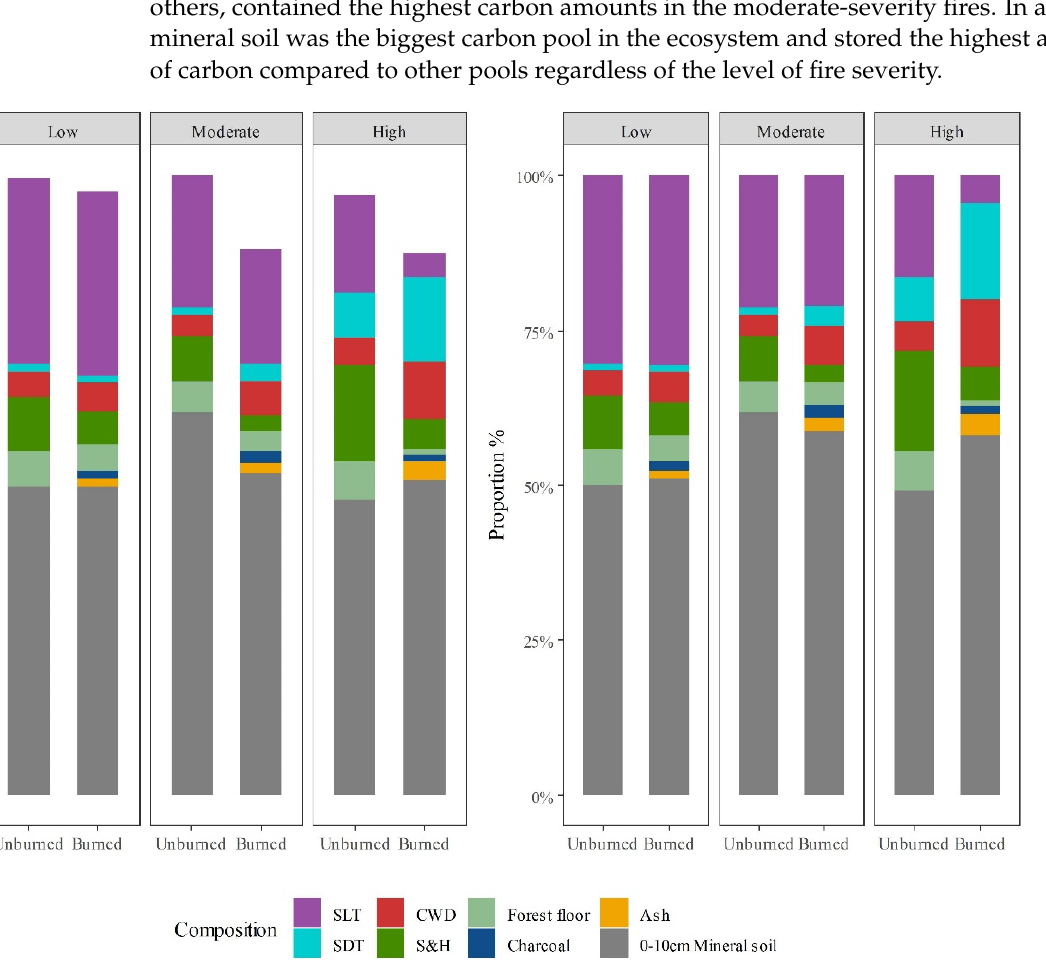
Figure 3. Carbon stocks ( left ) and proportions ( right ) of different forest carbon pools in unburned plots and those burned by low-, moderate-, and high-severity fires.